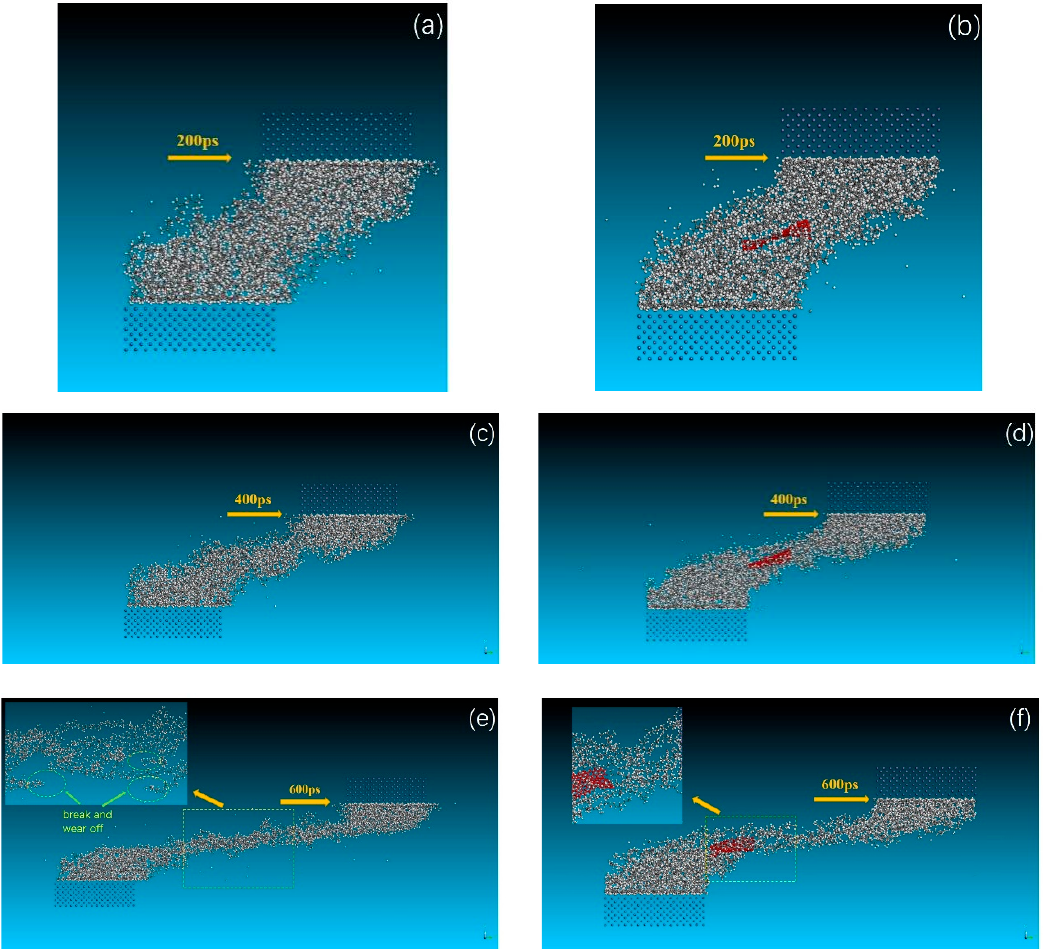
Figure 9. Friction process of the pure NR ( a , c , e ) and the GNS/NR composite ( b , d , f ) with a Fe layer at 200 ps, 400 ps, and 600